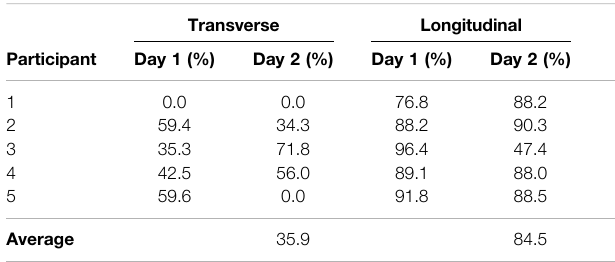
TABLE 3 | Percentage of transverse and longitudinal knee tissue bioimpedance classi fi ed as high-quality (e.g., not degraded) using threshold and trend analysis. Transverse